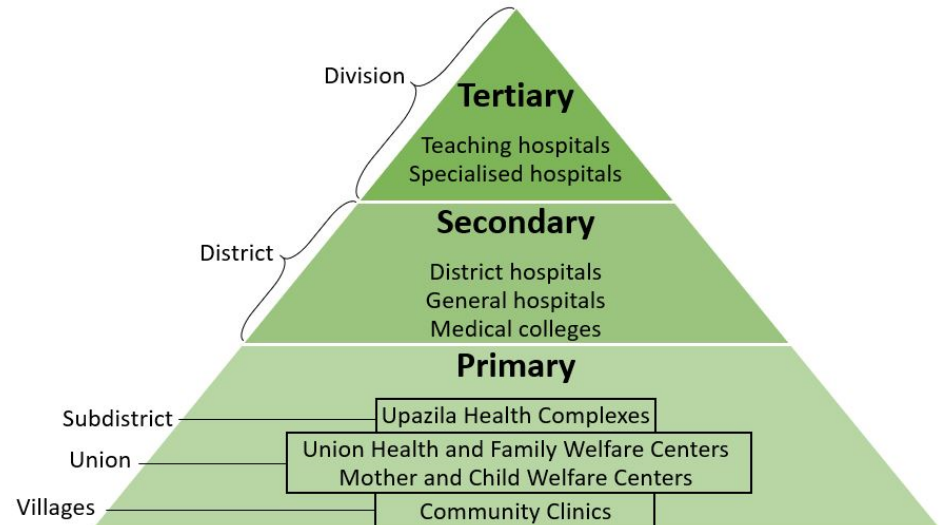
Figure 1. Health care system in